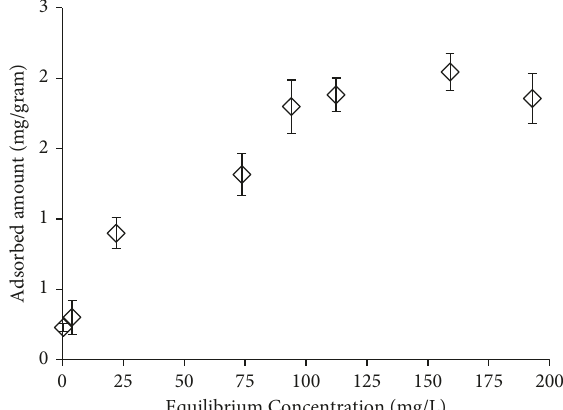
Figure 3: The adsorption isotherm of copper(II) to the biofilm. The experiment was repeated three times, independently (average values are shown). Bars represent the standard